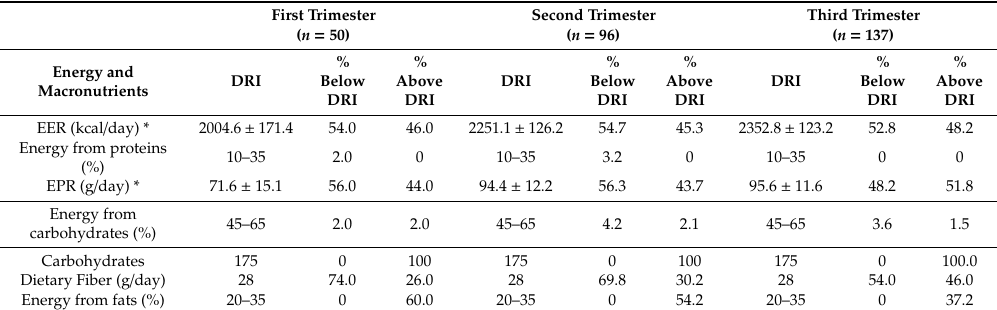
Table 3. The proportions of pregnant women that reported energy and the micronutrient intakes and protein, carbohydrate, and fat intakes as percentages of energy below or above the corresponding dietary reference